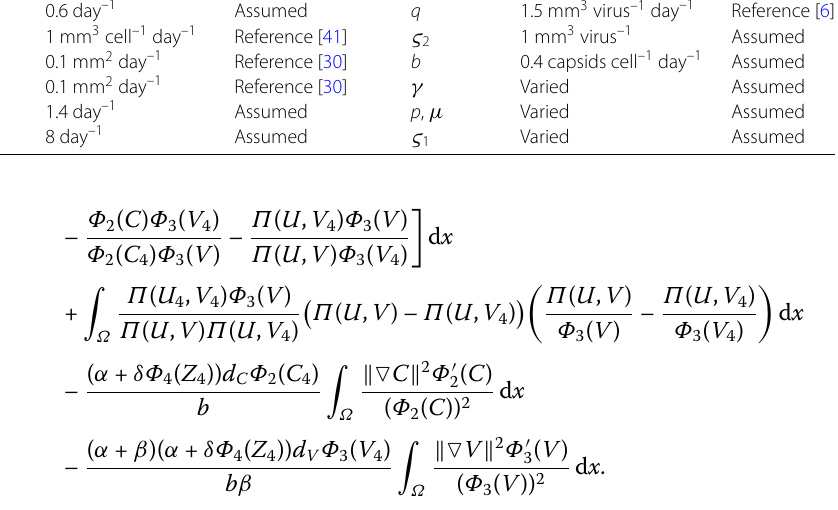
Table 1 List of parameters of model (44) Parameter Value Source Parameter Value Source